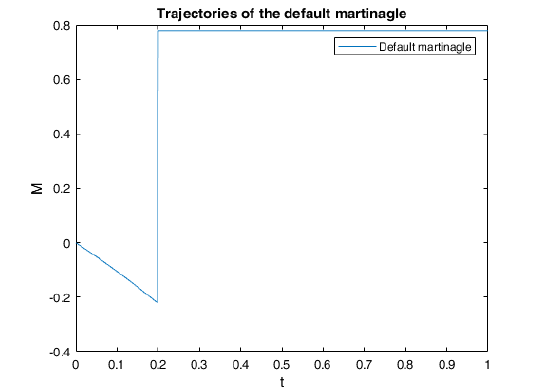
Figure 2. One path of the default martingale ( τ = 0.7).